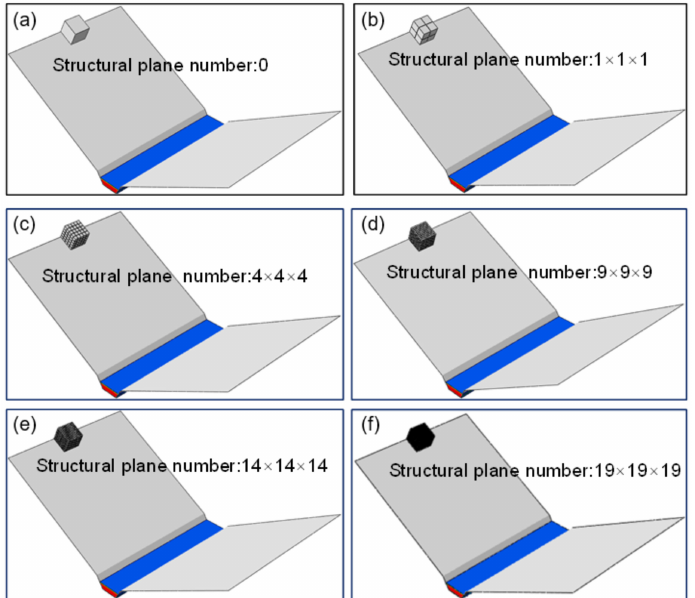
Figure 7. Six conditions of different fracturing degrees of a source rock: ( a ) structural plane number: 0; ( b ) structural plane number: 1 × 1 × 1 in each dimension; ( c ) structural plane number: 4 × 4 × 4 in each dimension; ( d ) structural plane number: 9 × 9 × 9 in each dimension; ( e ) structural plane number: 14 × 14 × 14 in each dimension; ( f ) structural plane number: 19 × 19 × 19 in each